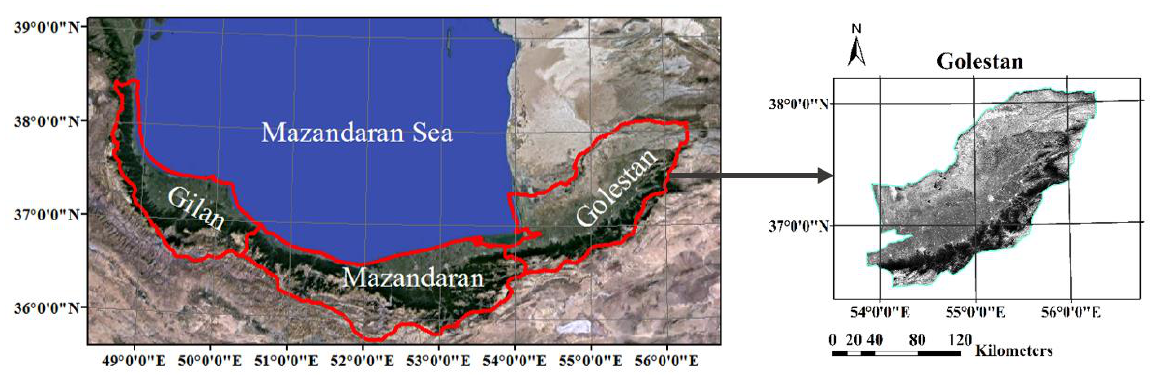
Figure 1. The study area is Golestan province located in the northern part of Iran, the northern slopes of the Alborz mountain range and in south coastal plain of Mazandaran sea